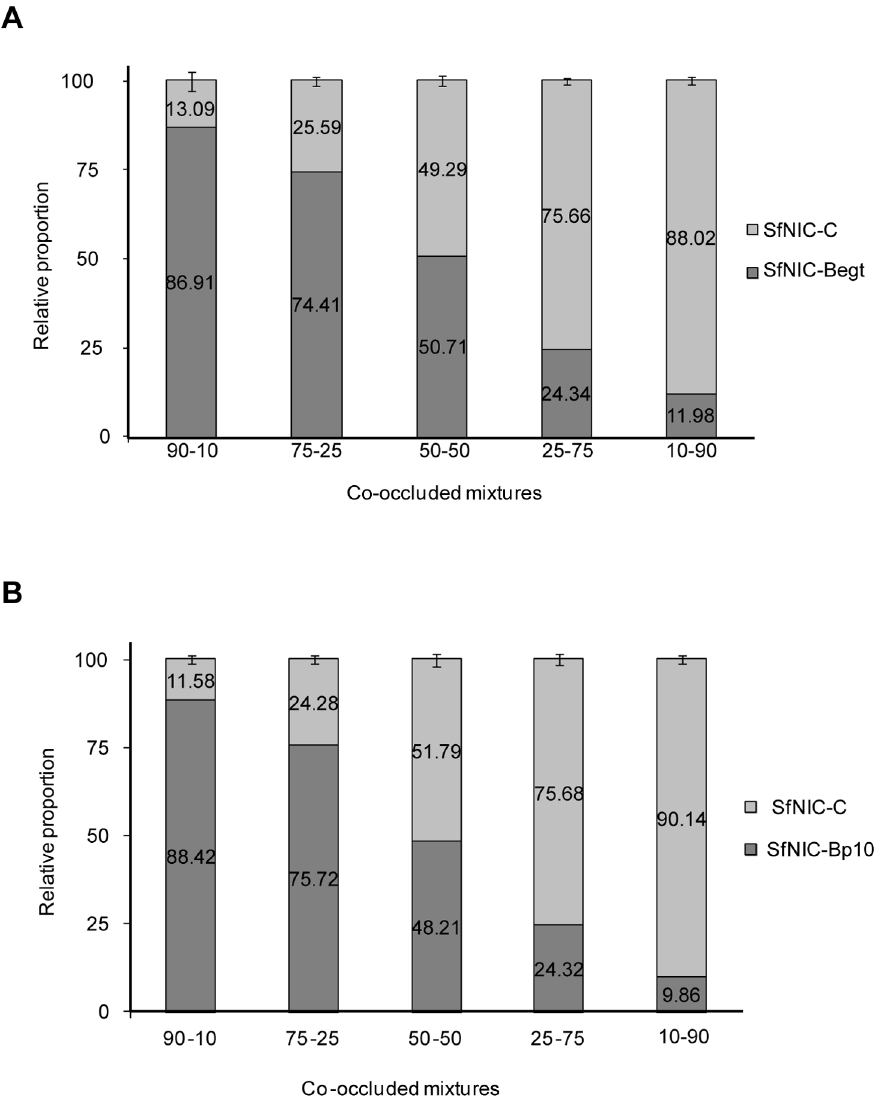
Figure 4. Relative proportions of SfNIC-Begt or SfNIC-Bp10 and SfNIC-C viruses in OBs comprising A) SfNIC-Begt:SfNIC-C and B) SfNIC-Bp10:SfNIC-C co-occluded mixtures at proportions of 90:10, 75:25, 50:50, 25:75 and 10:90. The relative proportion of each virus was determined by qPCR using DNA extracted from co-occluded mixed genotype OBs obtained after injection of S. frugiperda fourth instars using ODVs released from OB mixtures at the desired proportions. Primers qSfBpif1.F and qSfBpif1.R were used for amplification of SfNIC-Begt and SfNIC- Bp10, that did not amplify in SfNIC-C. Primers qSfCcath1.F and qSfCsf361.R were used for amplification of SfNIC-C.